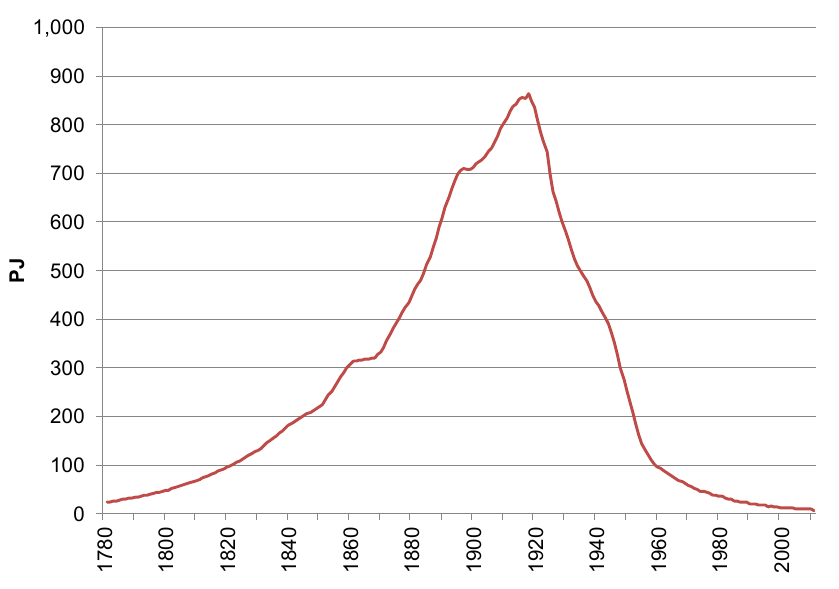
Figure 2. Draft animal energy inputs in the United States, 1780–2010. Sources: Draft animal populations from [6,12,13]. Post-1960 declined estimated based on 1945–1960 rate. Animal energy inputs estimated at 18,900 calories per day per animal, based on